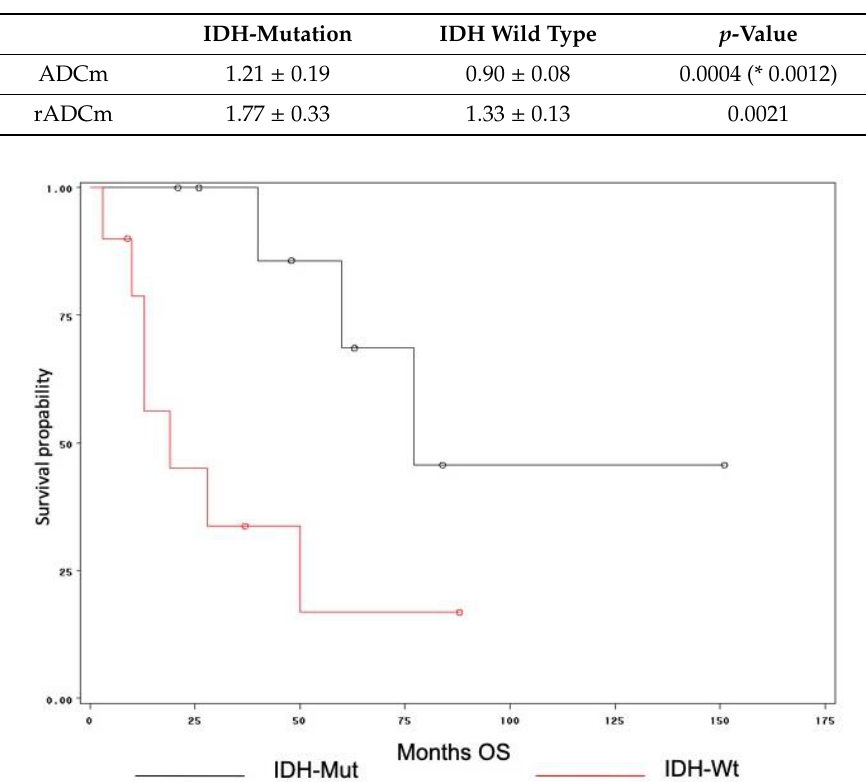
Table 2. Comparison of mean apparent diffusion coefficient (ADCm) and relative ADC (rADCm) values between IDH-mutant (Mut) and wild type (Wt) grade III astrocytomas. IDH-Mut tumors show significantly higher ADCm and rADCm values compared with IDH-Wt. Higher ADCm values in IDH-Mut grade III astrocytomas were confirmed also after statistical correction for location and age (*) . Figure 4. ( a , b ) Boxplots showing ADCm and relative ADC (rADCm) of IDH-Mut and IDH-Wt grade III astrocytomas. ADCm ( a ) and rADCm ( b ) differences are both significant for p < 0.01.